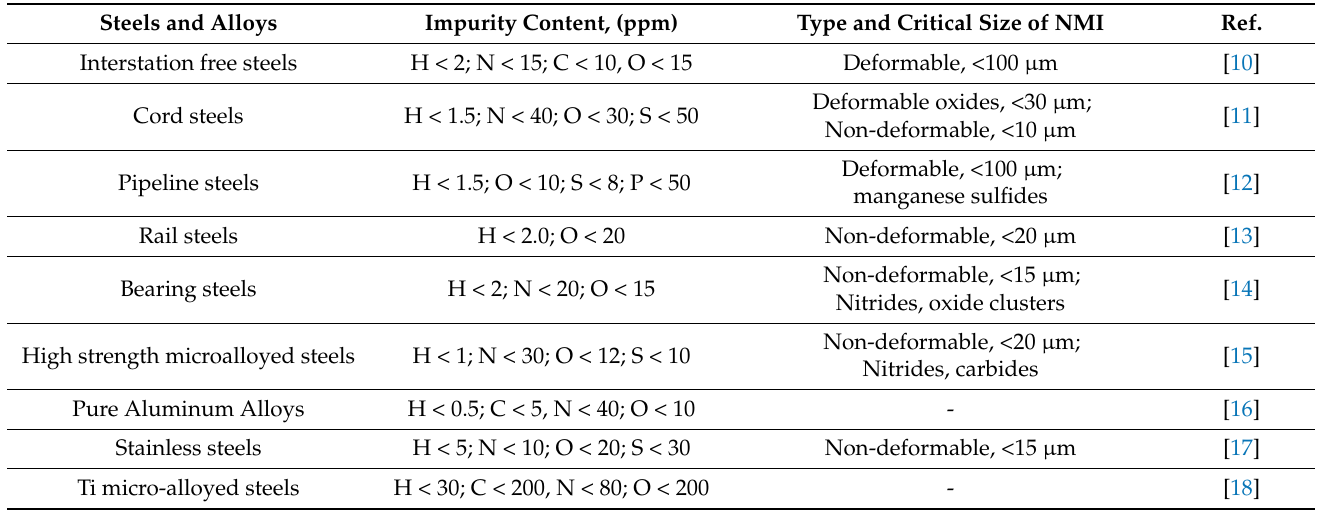
Table 1. Upper concentration limits of some elements in steels and alloys as well as critical sizes and types of non-metallic inclusions